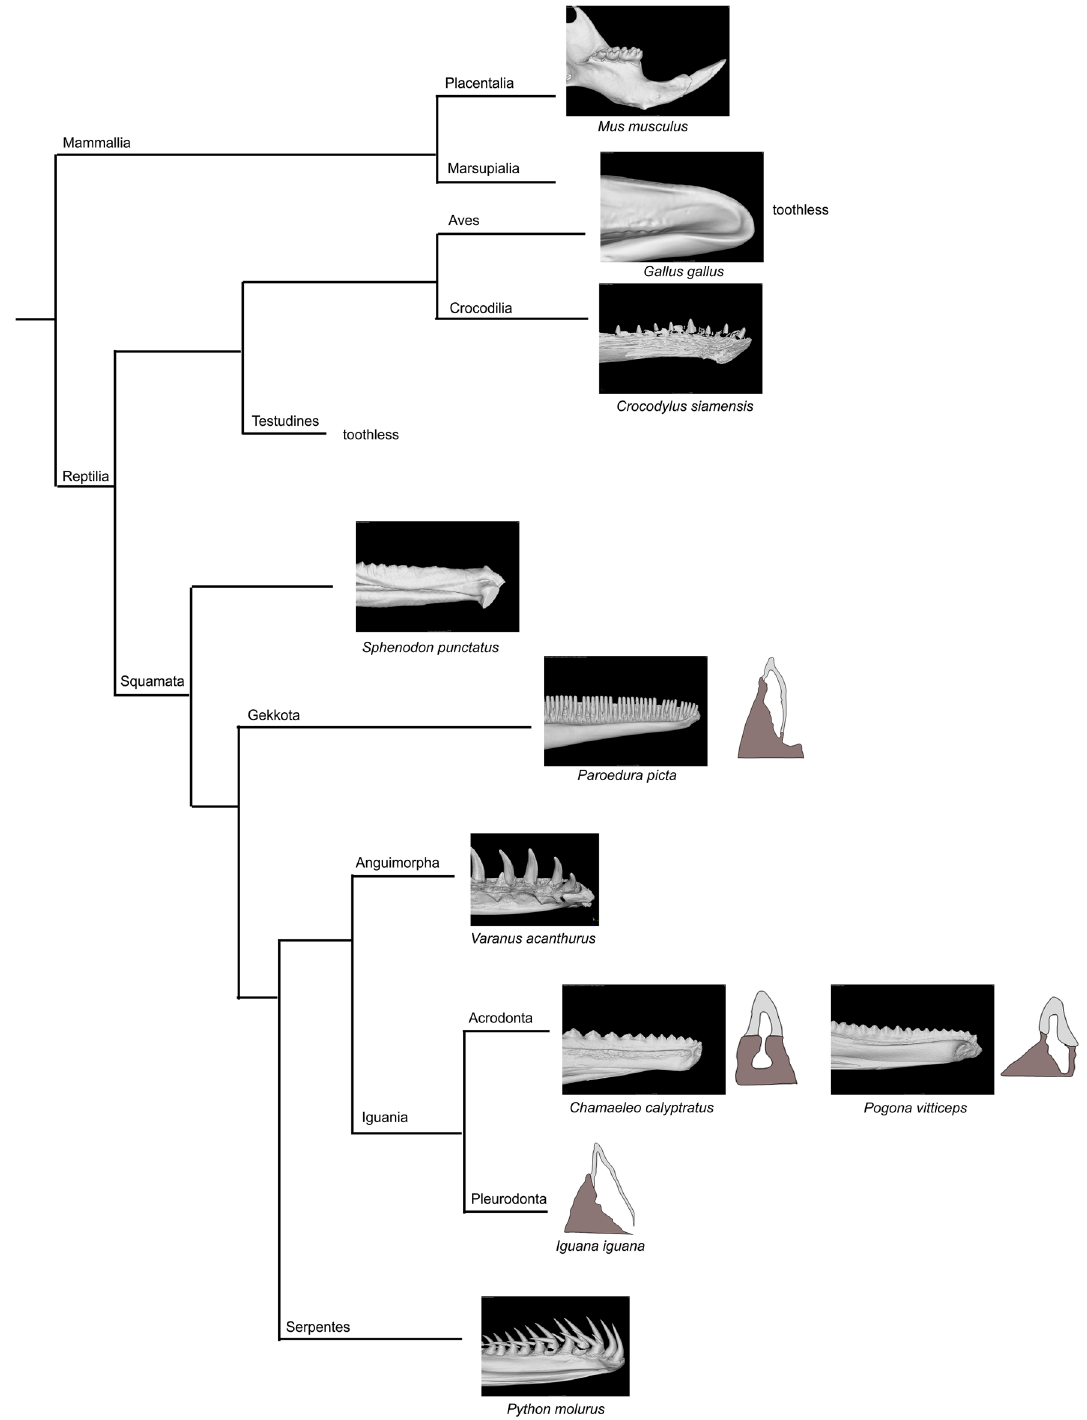
Figure 1. Simplified phylogenetic tree with displayed type of dentitions for selected species. Segment of the lower jaw in micro-CT view is displayed for selected vertebrate species to reveal possible tooth and bone relationship. Drawings of the transversal sections were modified based on 3 . Phylogenetic tree was adapted from 15 and 16